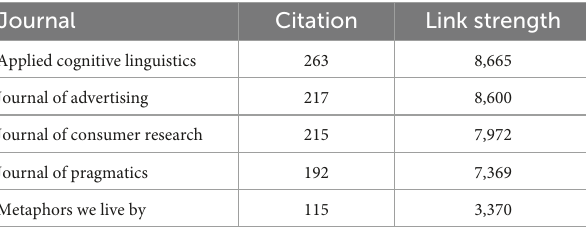
TABLE 3 Top five sources according to link strength from co-citation analysis by